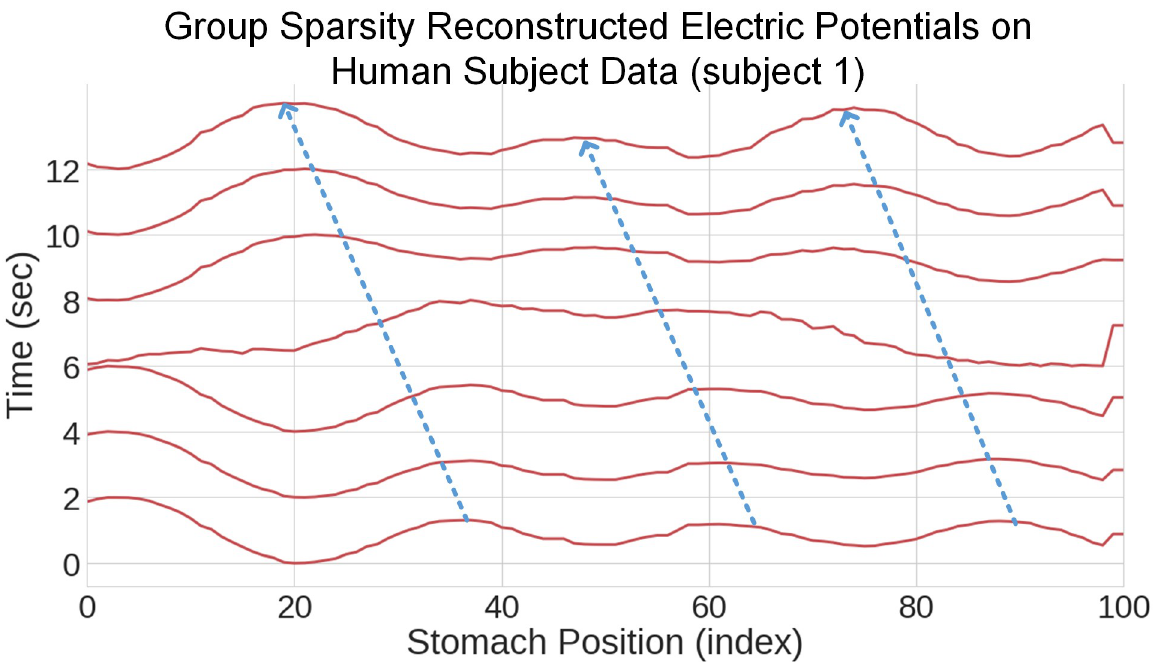
Fig 10. Inverse solution for human subject data. As with the simulated data, this represents twelve seconds of computed inverse data across the sources on the organoaxial curve.